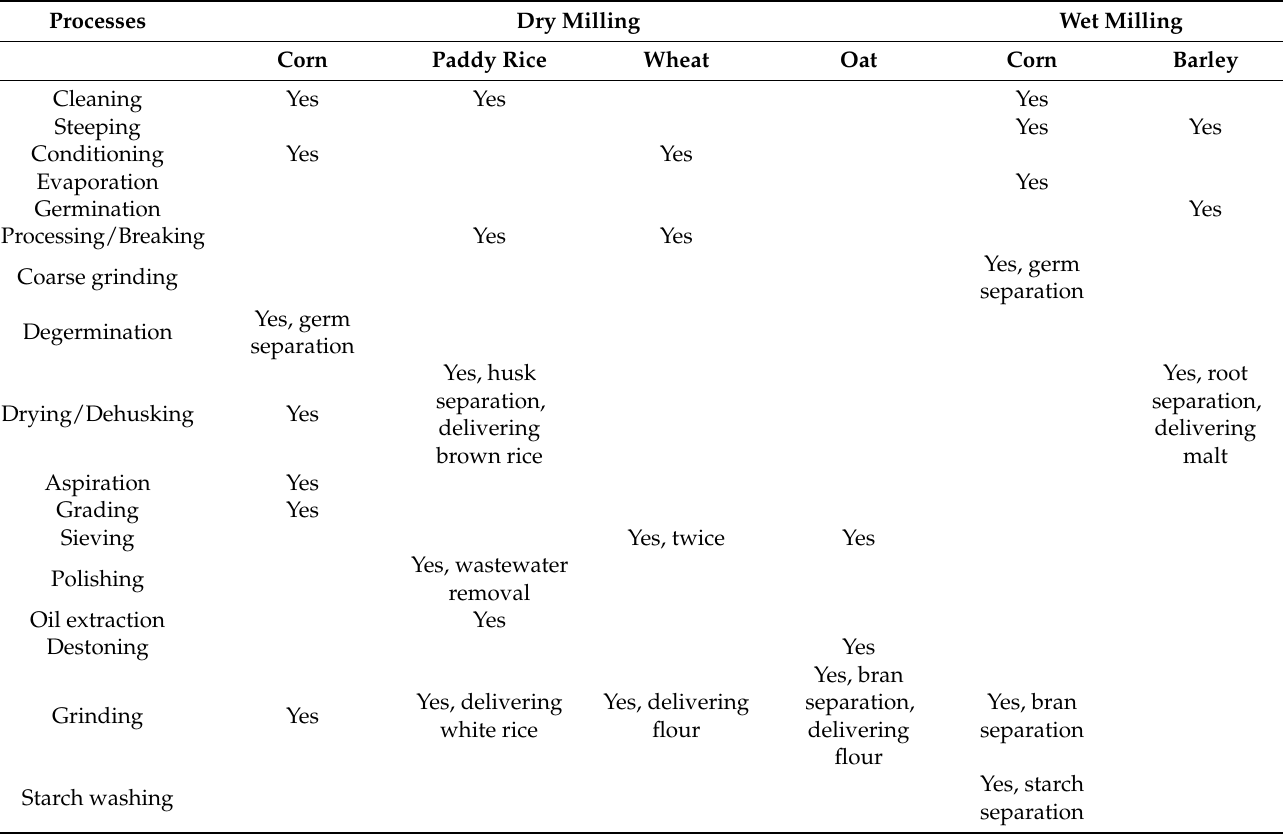
Table 1. Processing steps during the dry and wet milling of different